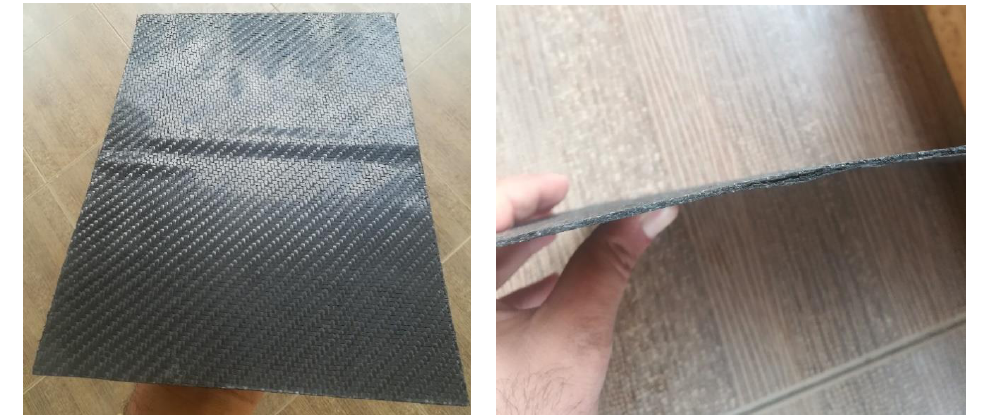
Figure 17. Manufactured plate failure.